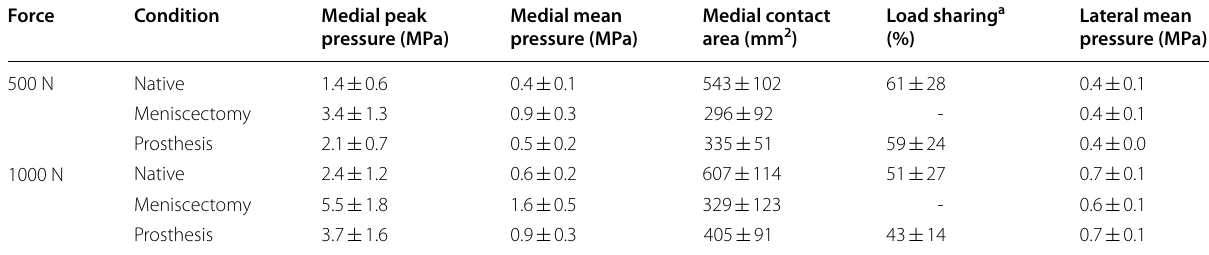
a Percentage of medial compartment load transferred through the meniscus or the